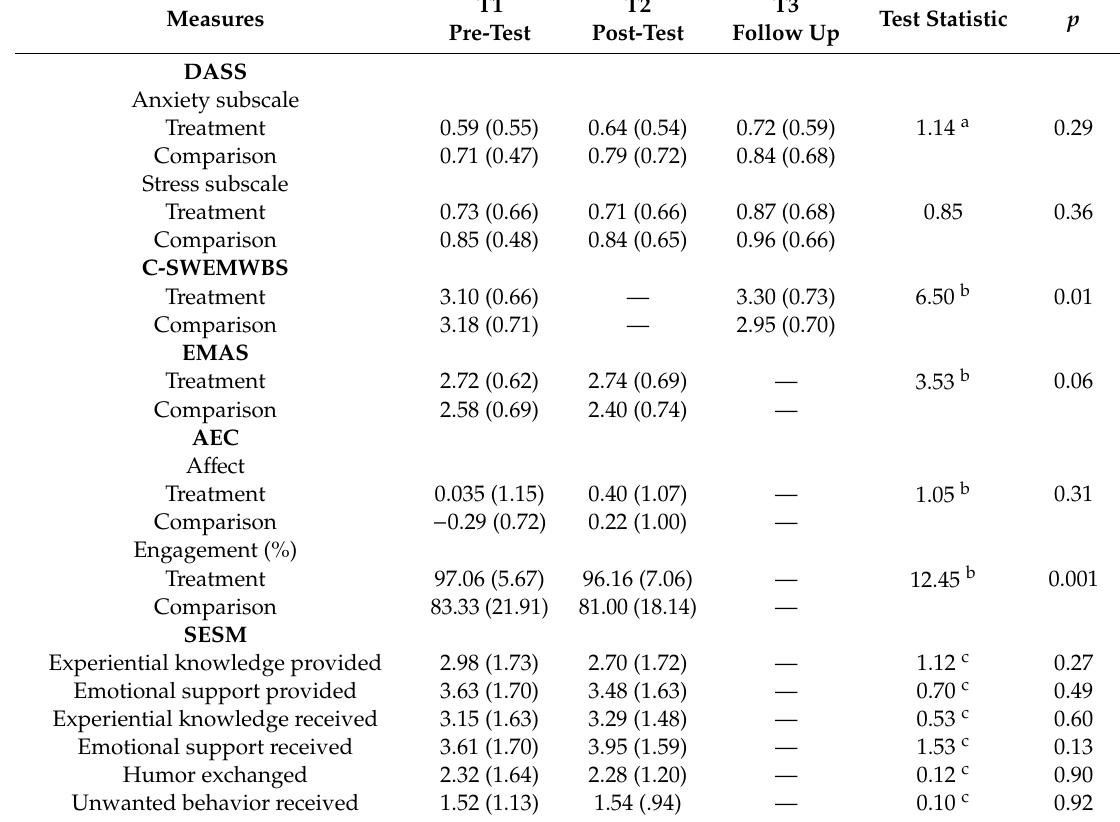
Table 3. Comparison of the outcomes of the treatment and control